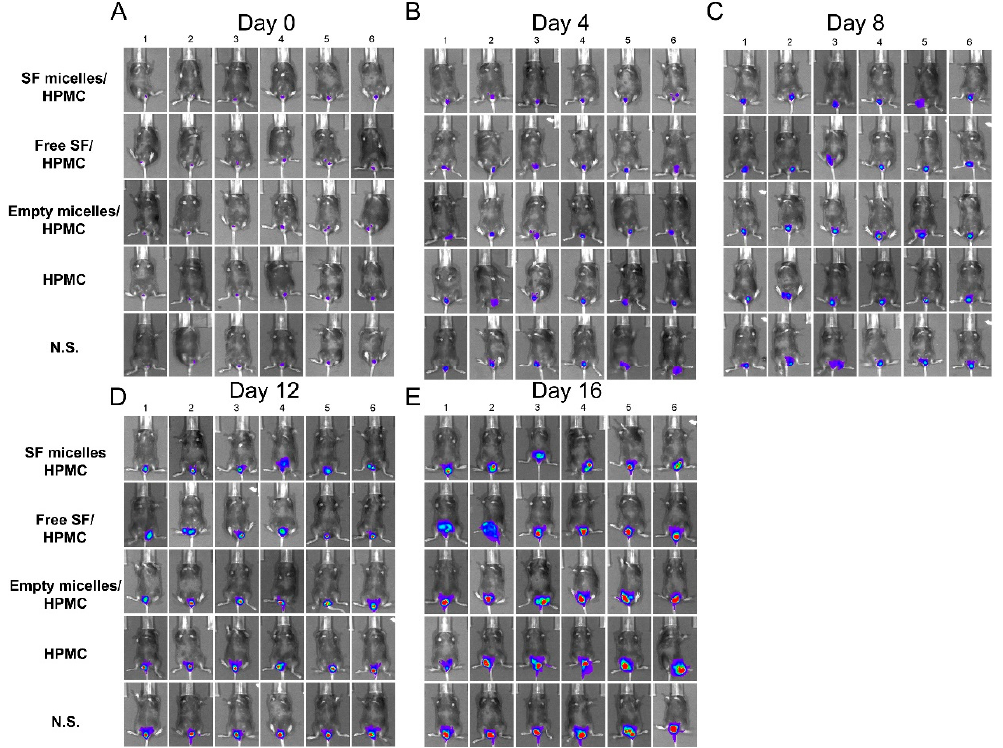
Figure A5. The bioluminescence images of SF micelles/HPMC, Free SF/HPMC, Empty micelles/HPMC, HPMC and N.S. group to the tumor-bearing mice at the day 0, day 4, day 8, day 12 and day16 (n = 6) ( A – E ).